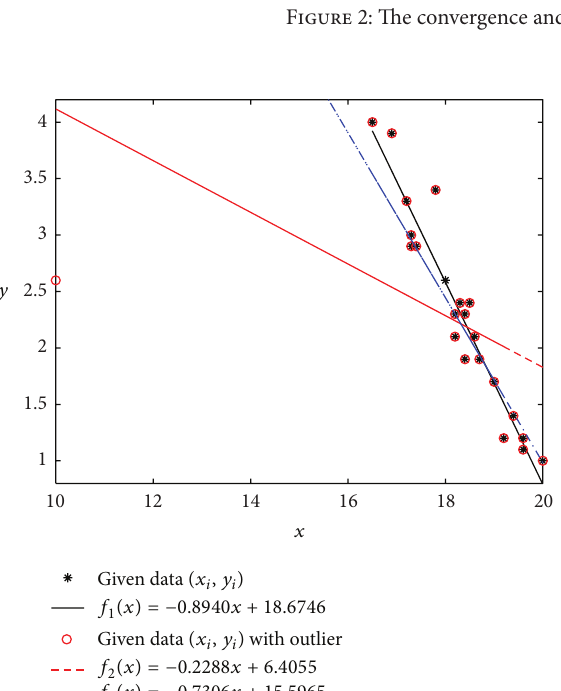
Figure 3: Data fitting results by LSR and LAD. Here 𝑓 1 (𝑥) = −0.8940𝑥+18.6746 is fitting results of data in Table 1 by LSR, 𝑓 −0.2288𝑥 + 6.4055 is fitting results of data in Table 2 by LSR, and (𝑥) = −0.7306𝑥 + 15.5965 is fitting results of data in Table 2 by 𝑓 3